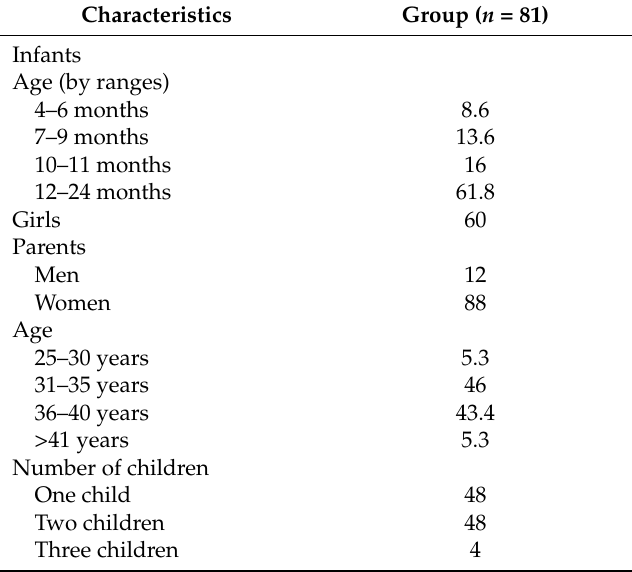
Table 2. Characteristics of infants and parents who participated in this study.